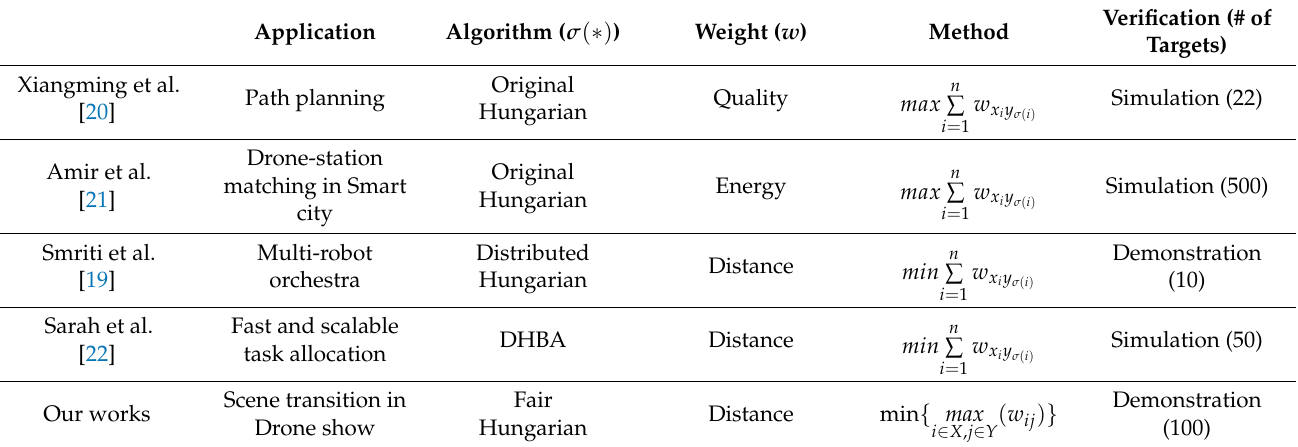
Table 1. Comparison with previous